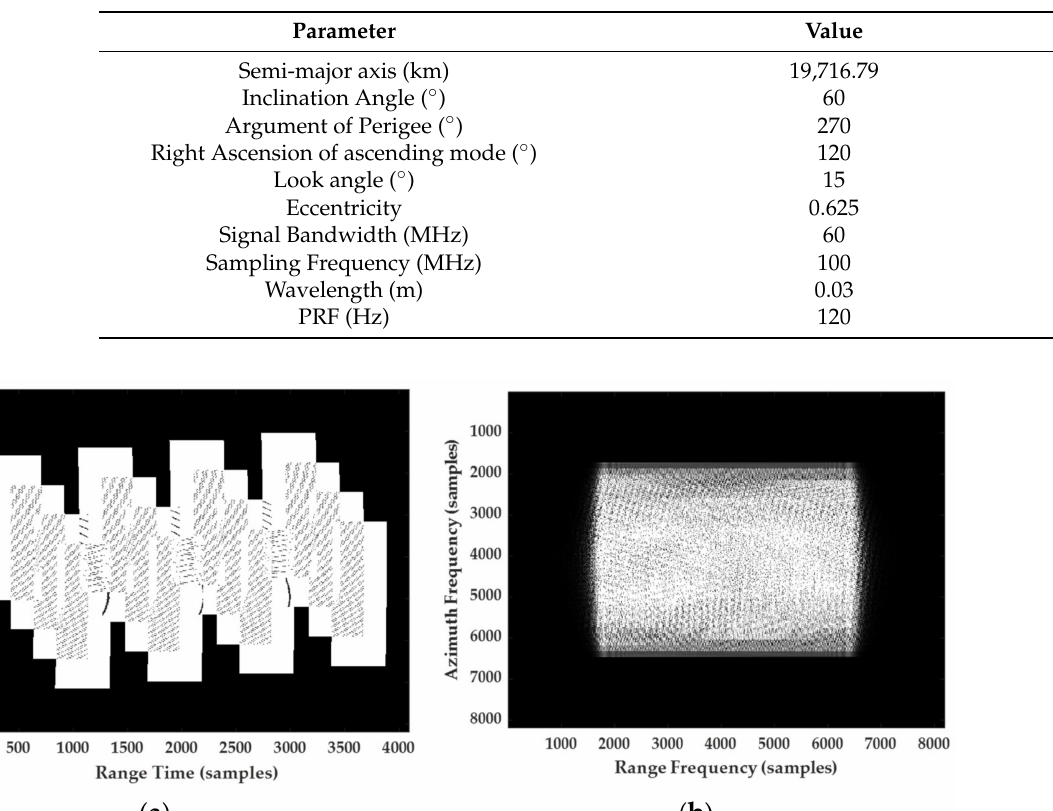
Table 4. Simulation Parameters for scene targets at apogee.